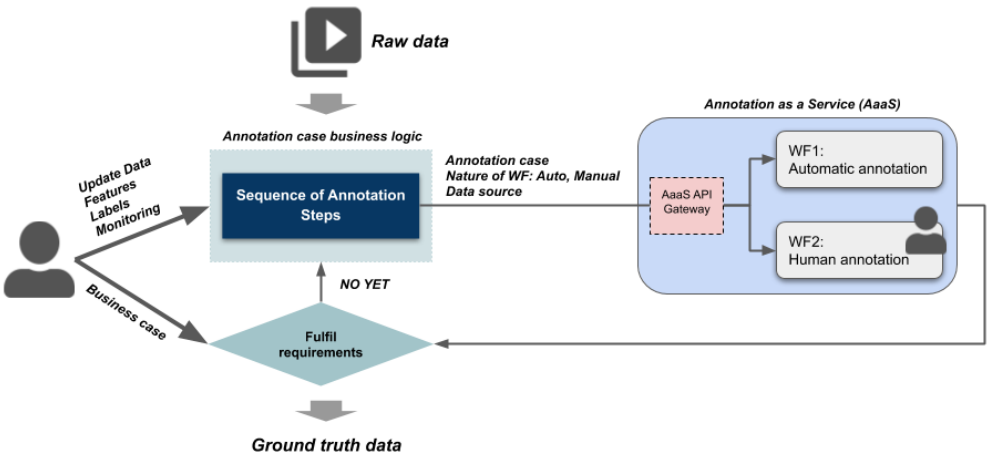
Figure 1. Business logic for the proposed semi-automatic for AD/ADAS (Autonomous Driving/Advanced Driver Assistance Systems) based Annotation as a Service